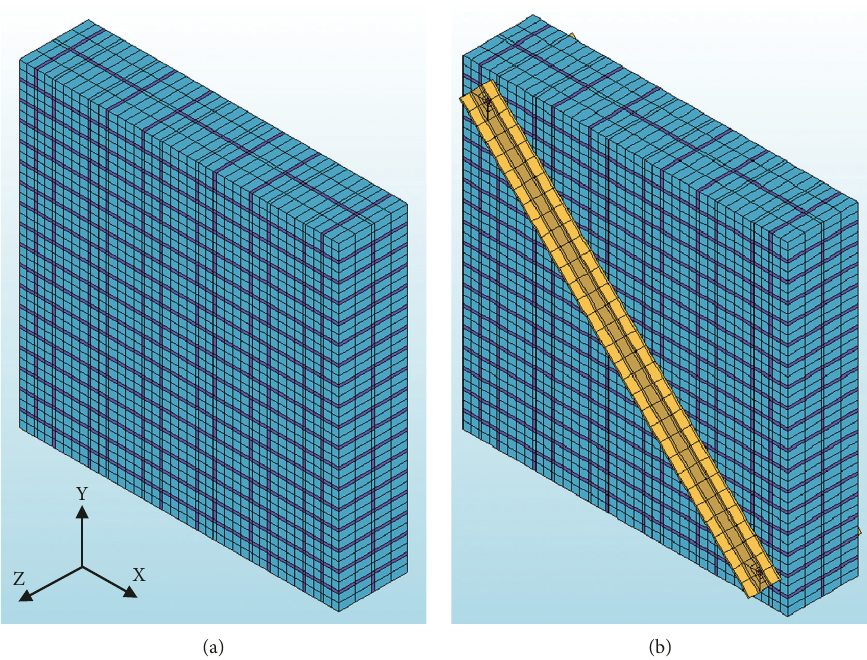
Figure 9: 3D models of the tested joint transposed on a 116